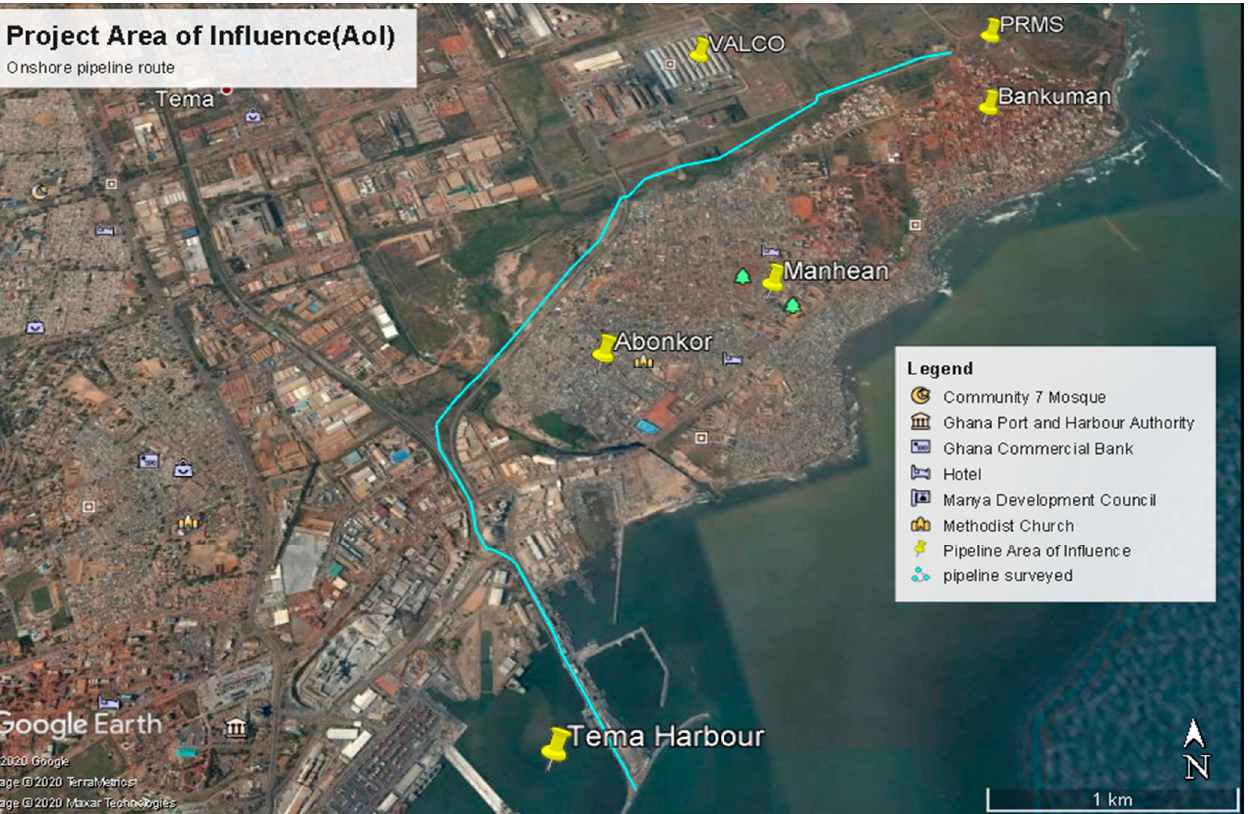
Figure 2. Location of study area (source: Google Earth accessed in January 2020).